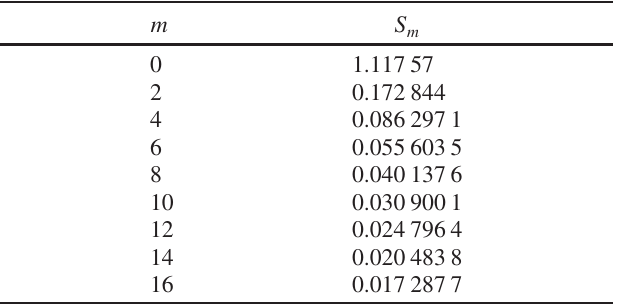
TABLE I. Nonvanishing S m for j m j ≤ 16 from Eqs. (23) and (24). m S